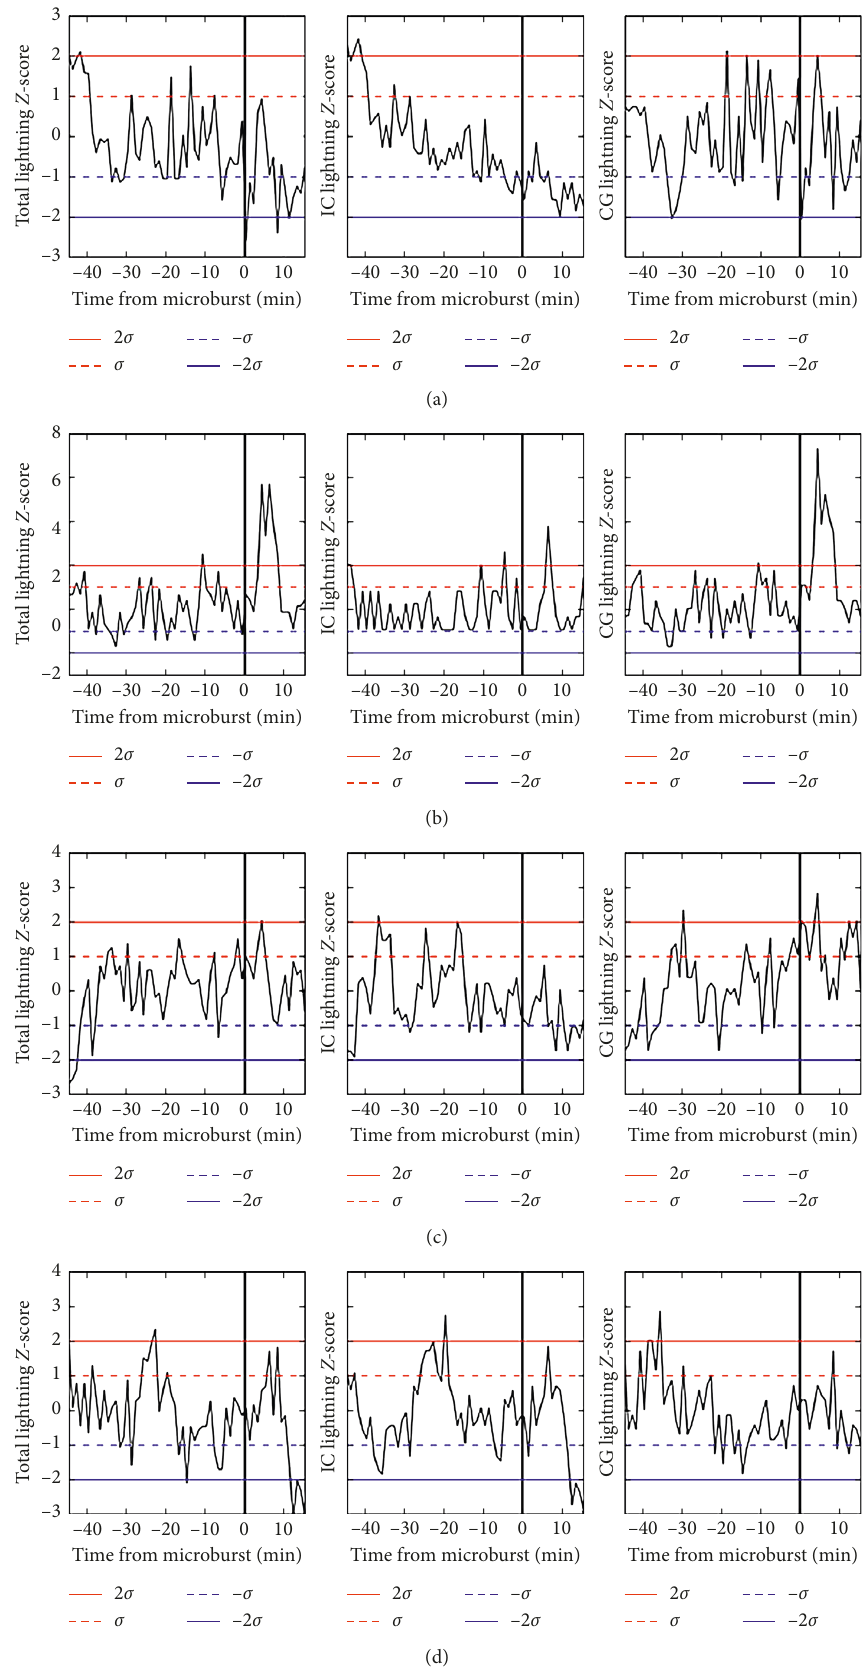
Figure 3: Plots of total lightning, IC lightning, and CG lightning for the first four microburst cases. (a) 20120724 microburst. (b) 20130624 microburst. (c) 20140703 microburst. (d) 20140708NY